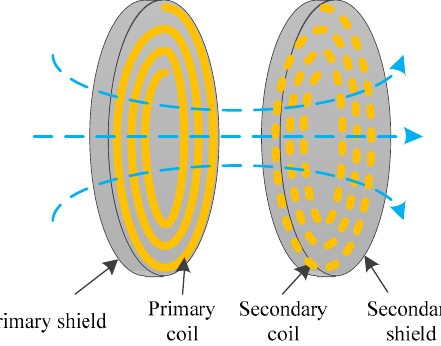
Figure 3. Basic structure of the loose coupler.